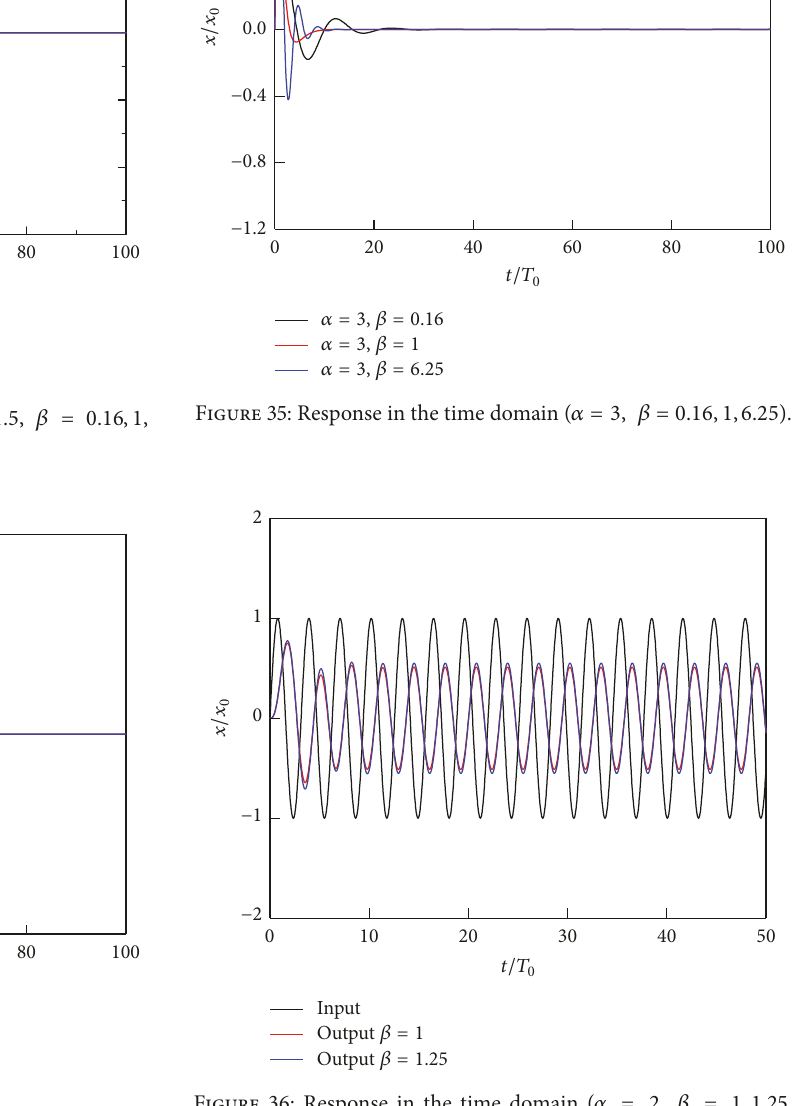
Figure 34: Response in the time domain ( 𝛼 = 2, 𝛽 = 0.16, 1,6.25 ).